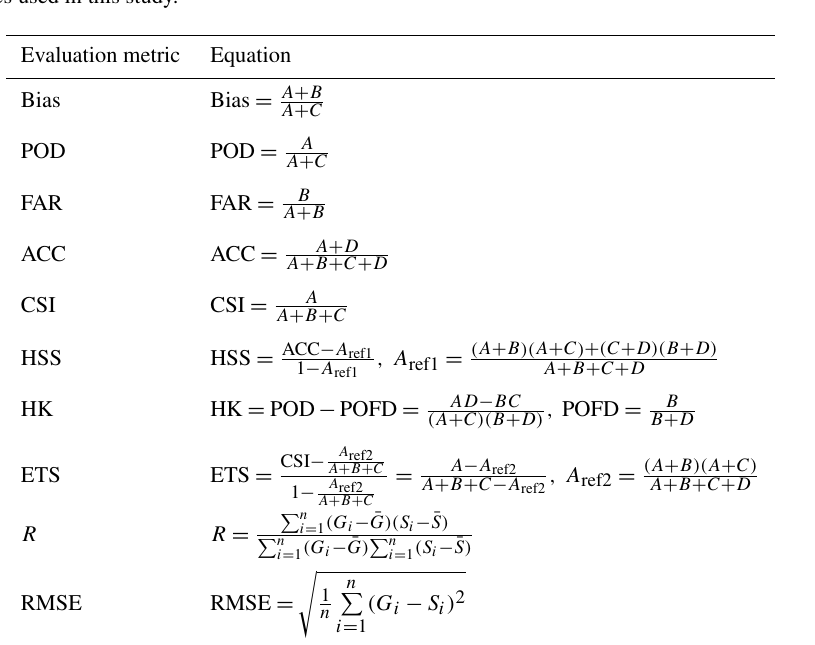
Table 2. Evaluation metrics used in this